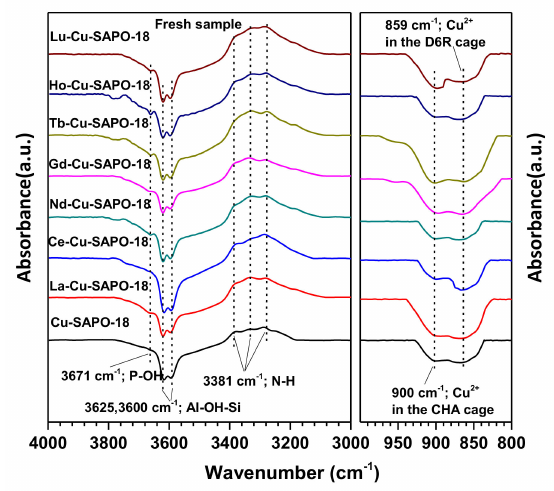
Figure 12. DRIFT spectra of NH 3 adsorbed on the fresh Cu-SAPO-18 and M-Cu-SAPO-18 samples. Experimental conditions: the sample was exposed to 500 ppm NH 3 (N 2 as the balance gas) at 30 o C for 1 h, and the total flow was 100 mL / min.